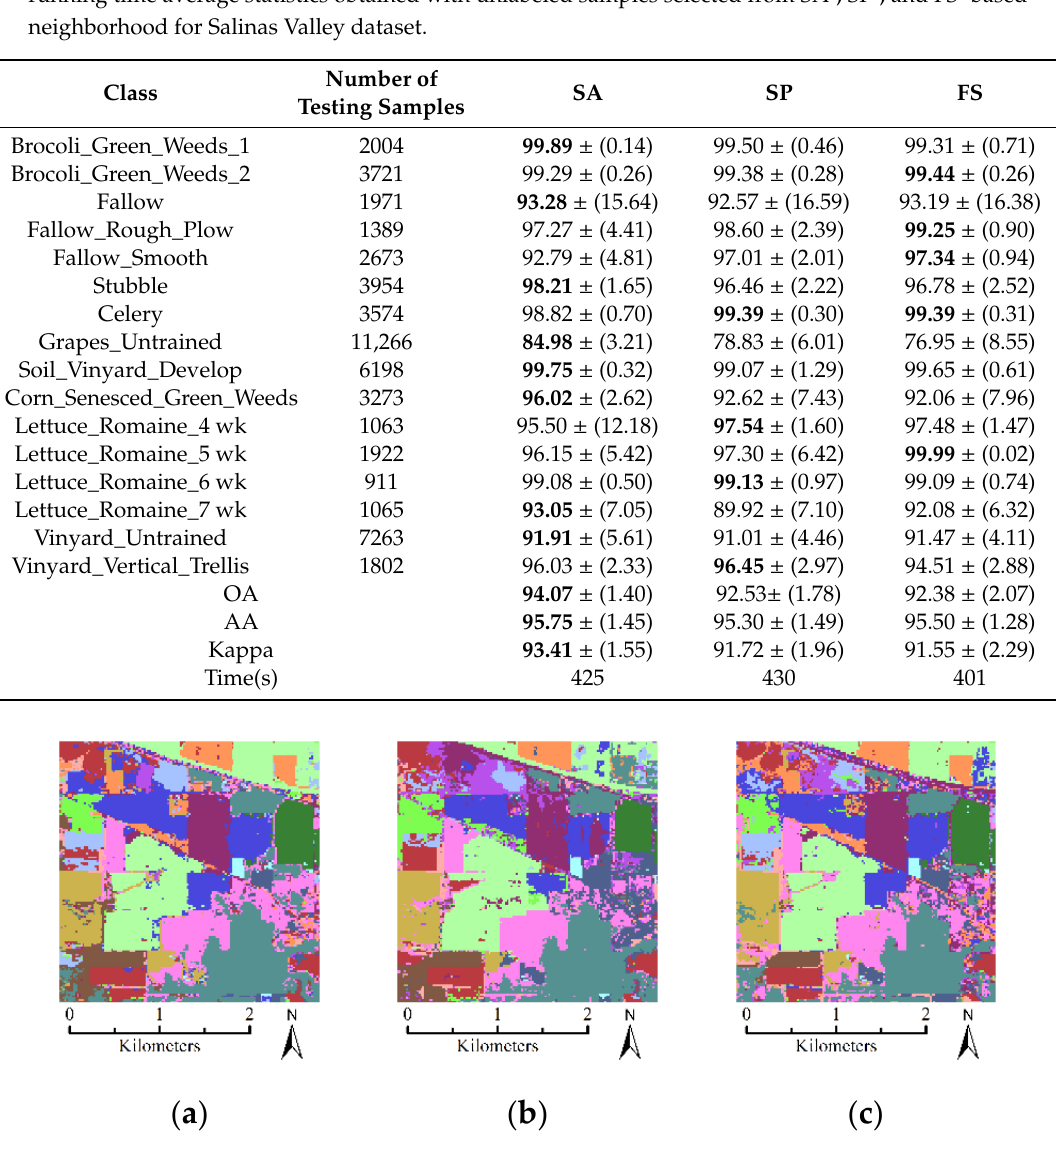
Figure 9. Classification maps of Indian Pines dataset obtained by using different spatial neighborhood information: ( a ) SA (86.82%); ( b ) SP (82.55%); and, ( c ) FS (84.71%).